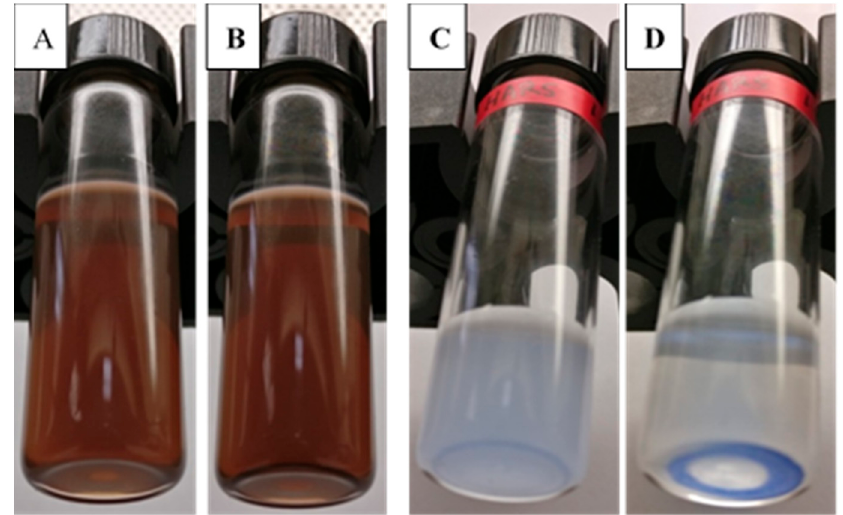
Figure 3. Properties of MOBs in solution: AgCysNPs ( A , B ) as synthesized or CuHARS ( C , D ) at 1 mg/mL were vortexed, followed by 90 min of settling time at room temperature (B,D).